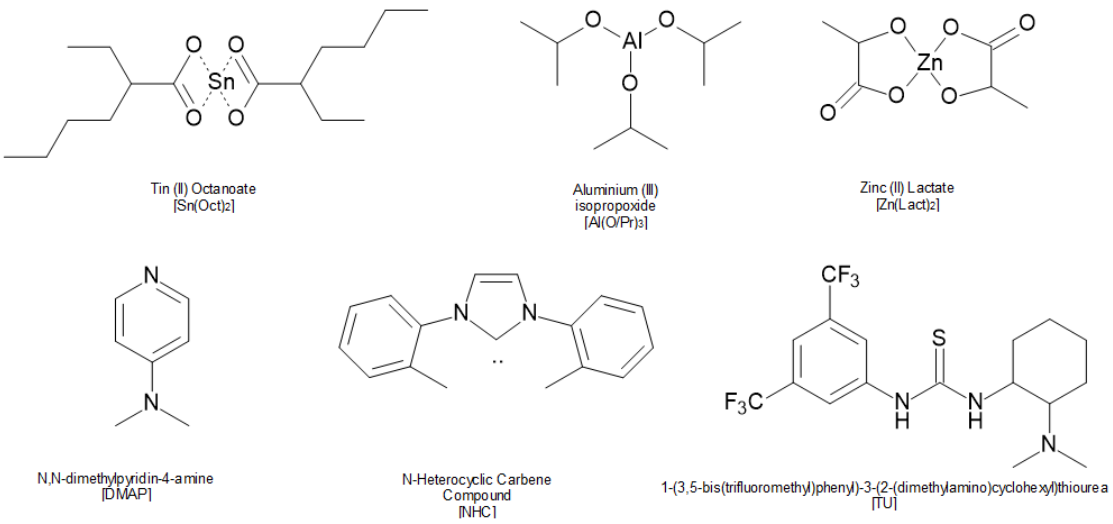
Figure 13. Structure of organometallic catalysts and organocatalysts used in PLA polymerization [6].